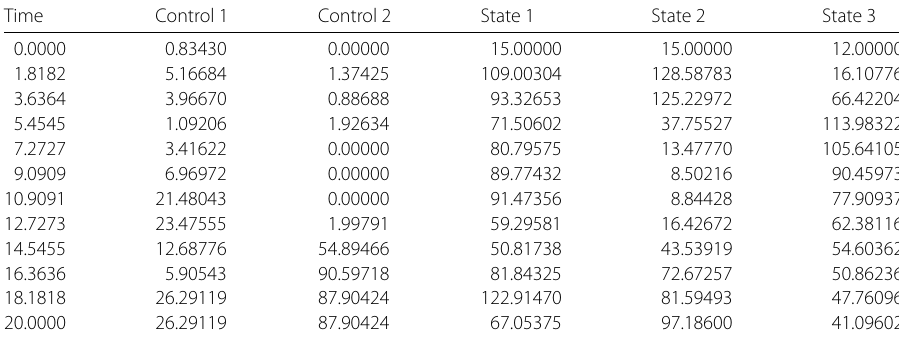
Table 1 The optimal control and states variables of (P) Time Control 1 Control 2 State 1 State 2 State 3 0.0000